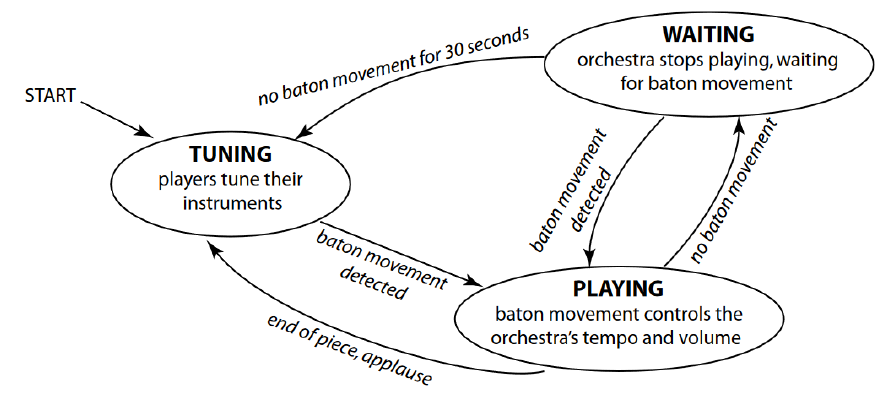
Figure 9. State machine for You’re the conductor